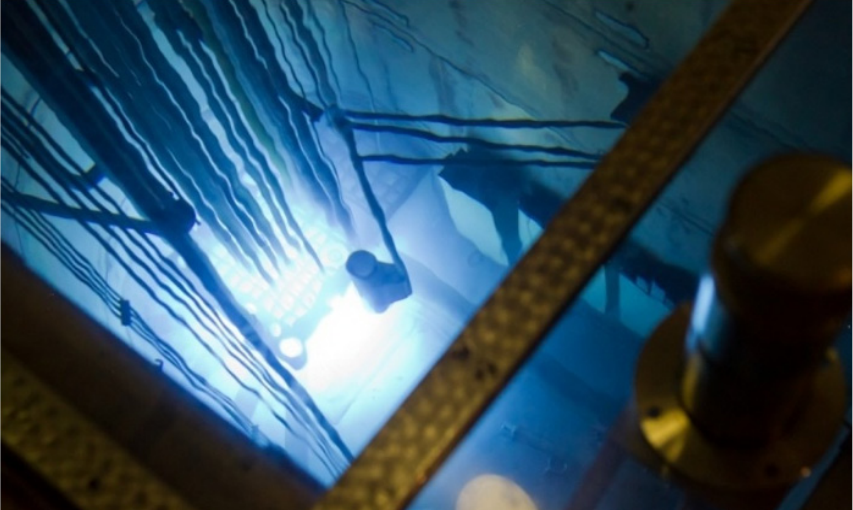
Fig. 3. Reactor`s active